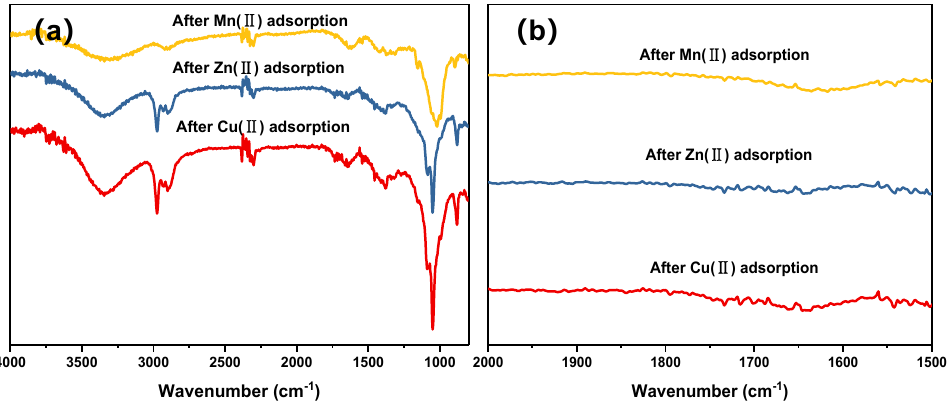
Figure 7. FTIR results of Zn(II), Mn(II), and Cu(II) adsorption. ( a ): The range of wavenumber is 4000–600 cm − 1 ; ( b ): The range of wavenumber is 4000–600 cm − 1